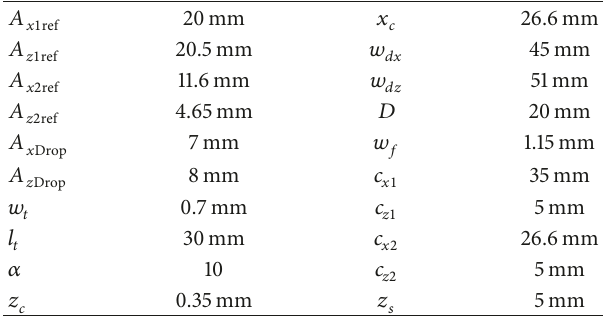
Table 1: Parameters describing the geometry of the drop-shaped antenna equipped with the metal reflector.